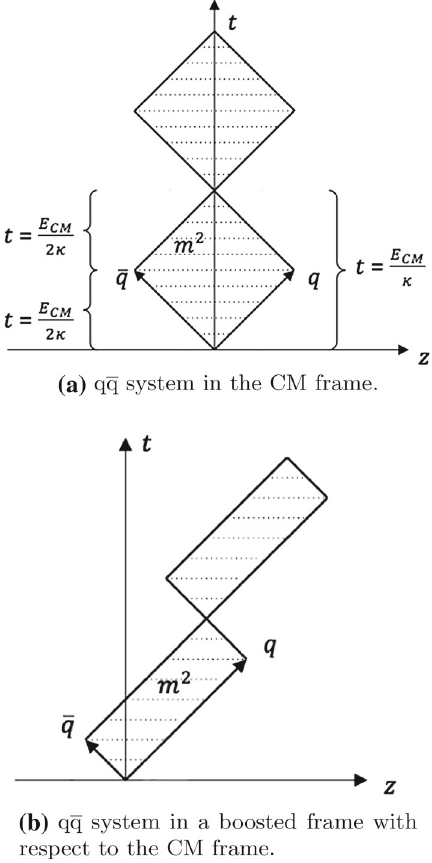
Fig. 2 The motion of a q ¯ q system, with massless q and ¯ q